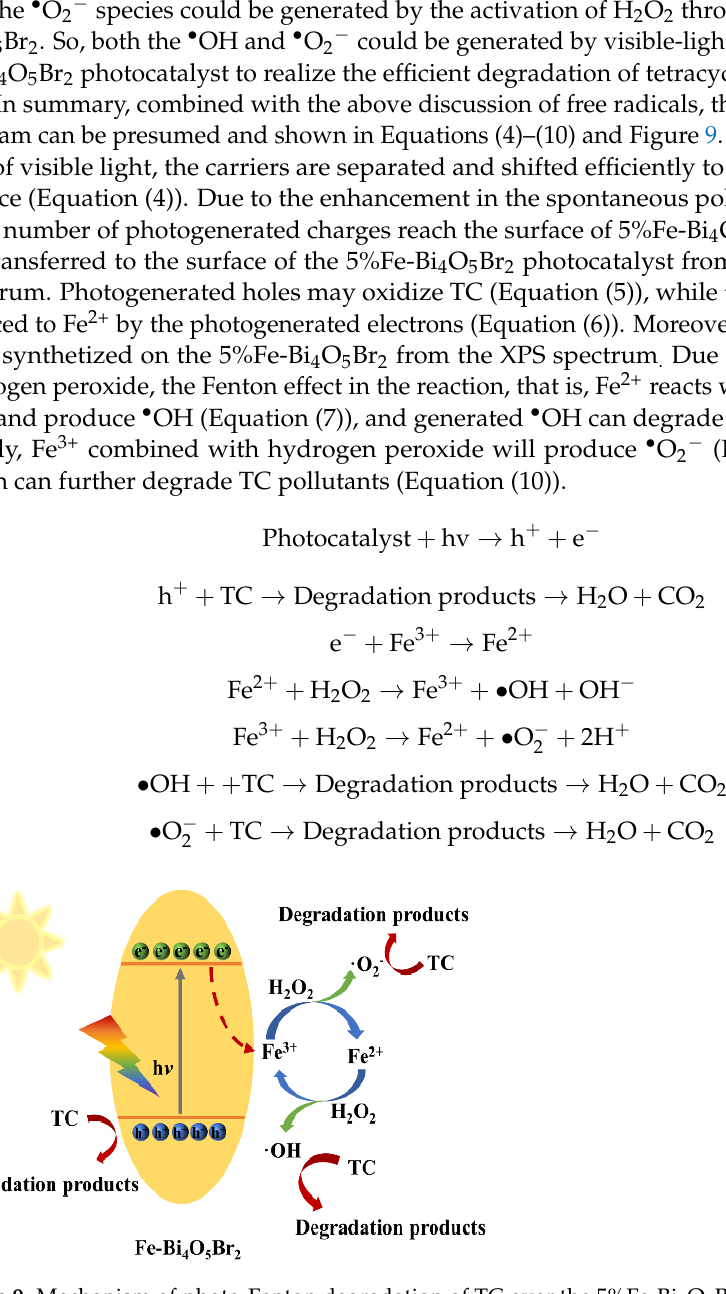
Figure 9. Mechanism of photo-Fenton degradation of TC over the 5%Fe-Bi 4 O 5 Br 2